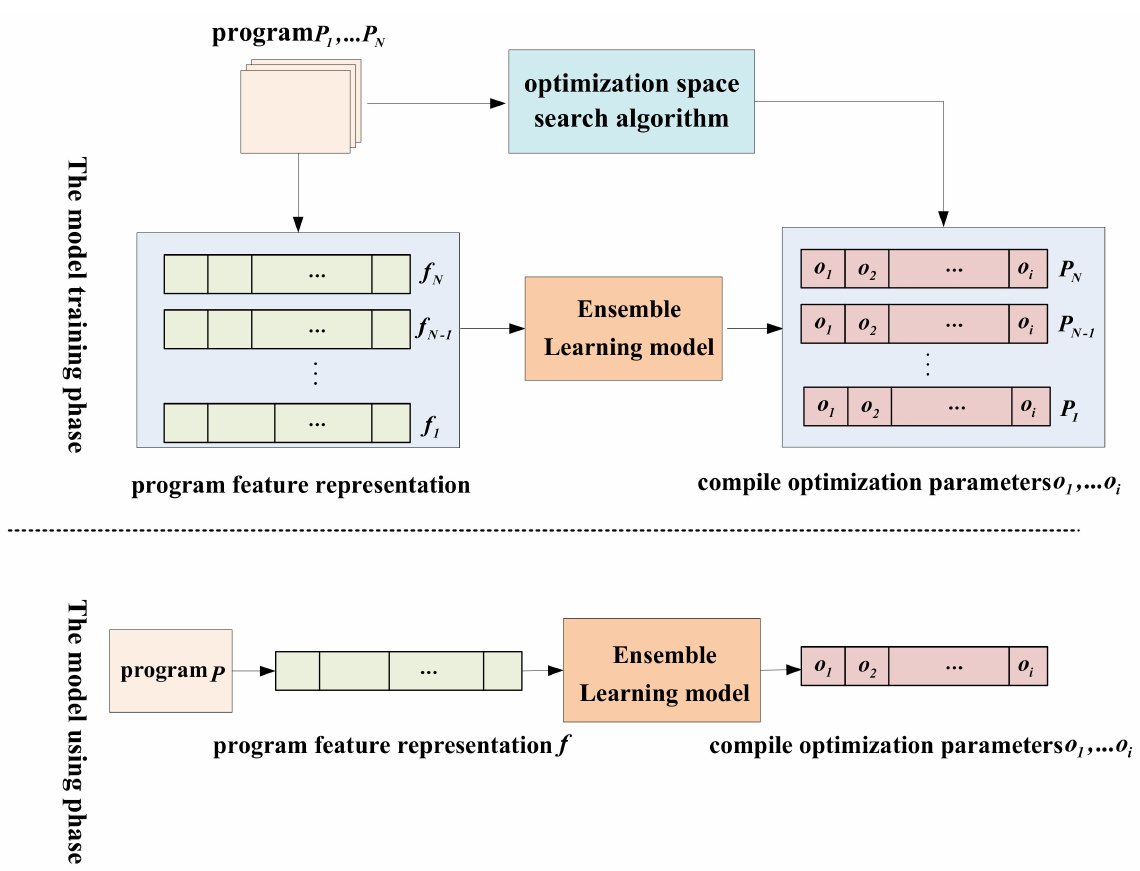
Figure 4. Compiler optimization parameter selection model